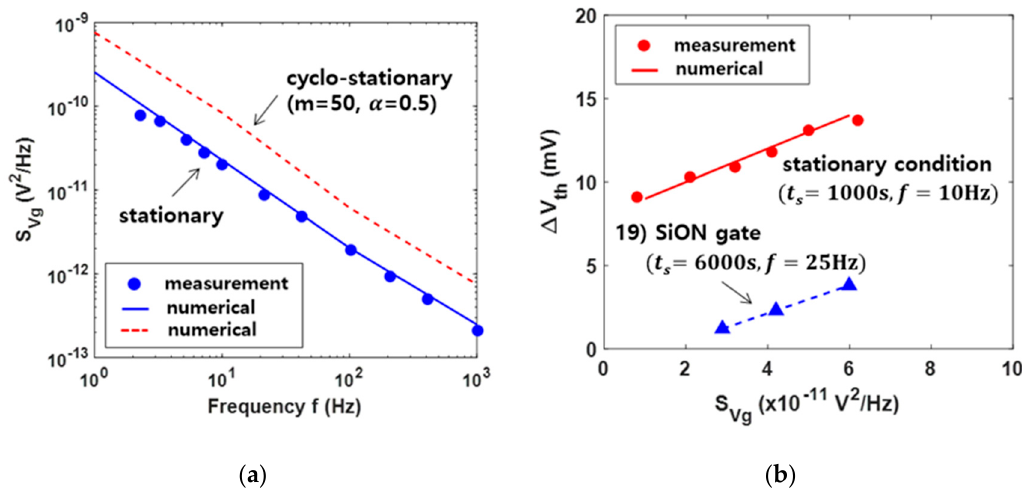
(𝜔) for 𝑉 (cid:3034)(cid:3046) = −2V , 𝑁 (cid:3047)∗ = 2.0 (cid:3400) 10 (cid:2869)(cid:2870) cm (cid:2879)(cid:2870) ( b ) ( ω ) for V gs = − 2 V, N ∗ (cid:3282) g